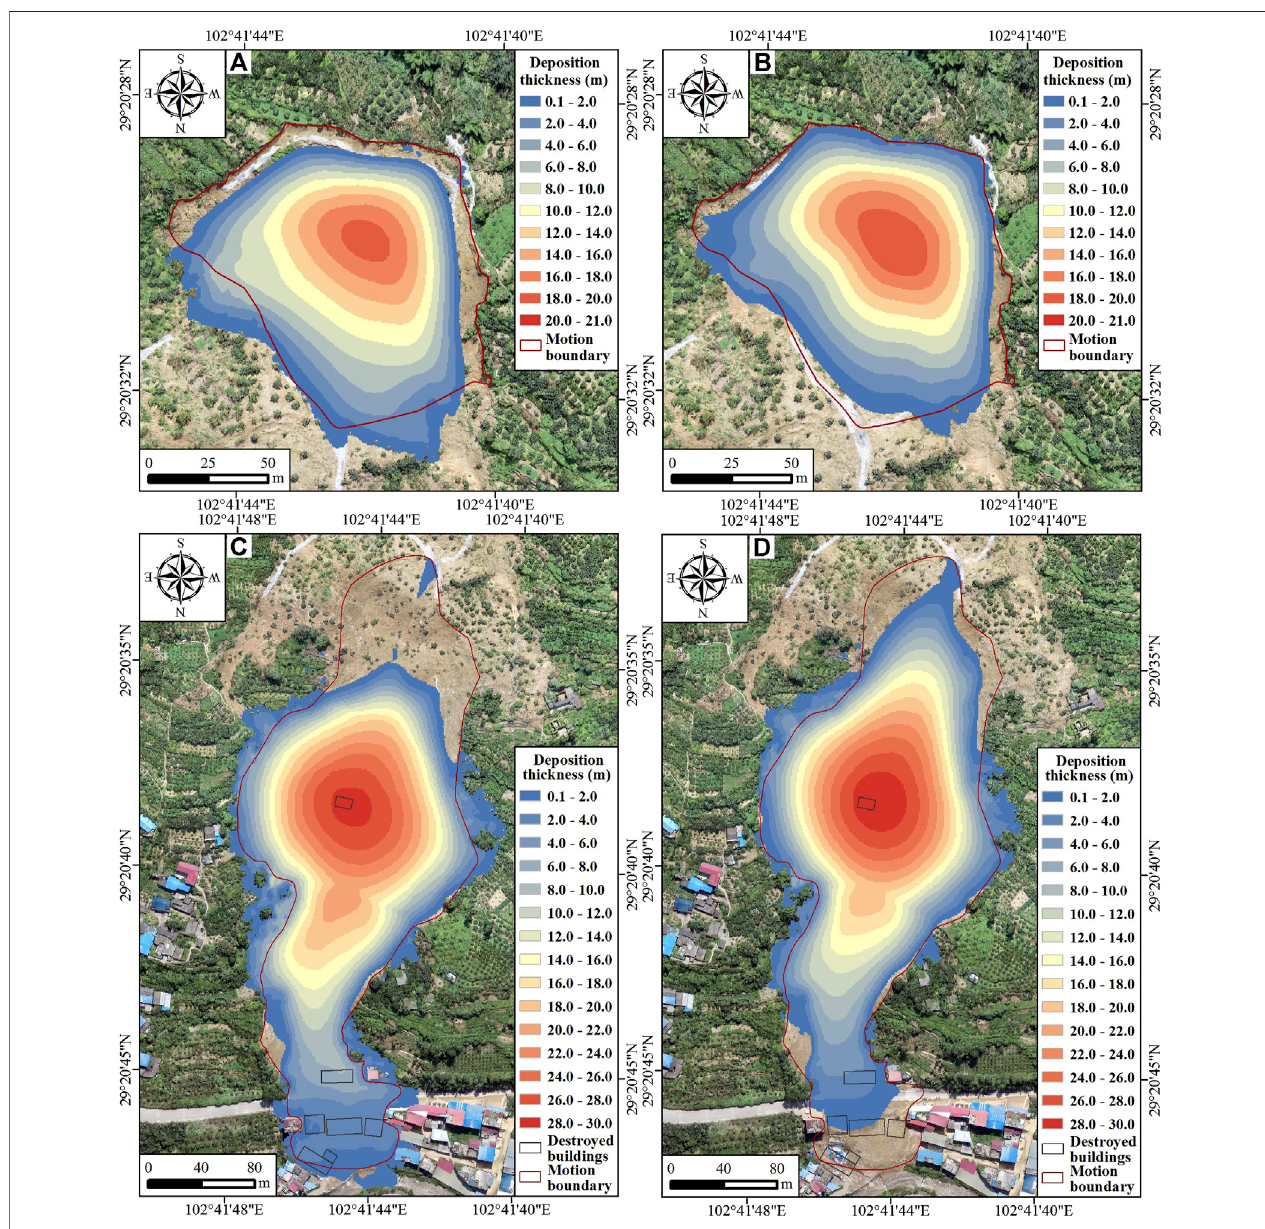
FIGURE11| The fi nal depthcontours oftheinitial landslide (A) with μ (cid:2) 0.45, (B) with μ (cid:2) 0.55. The fi nal depthcontours ofthe mainlandslide (C) with μ (cid:2) 0.27, (D) with μ (cid:2) 0.31.